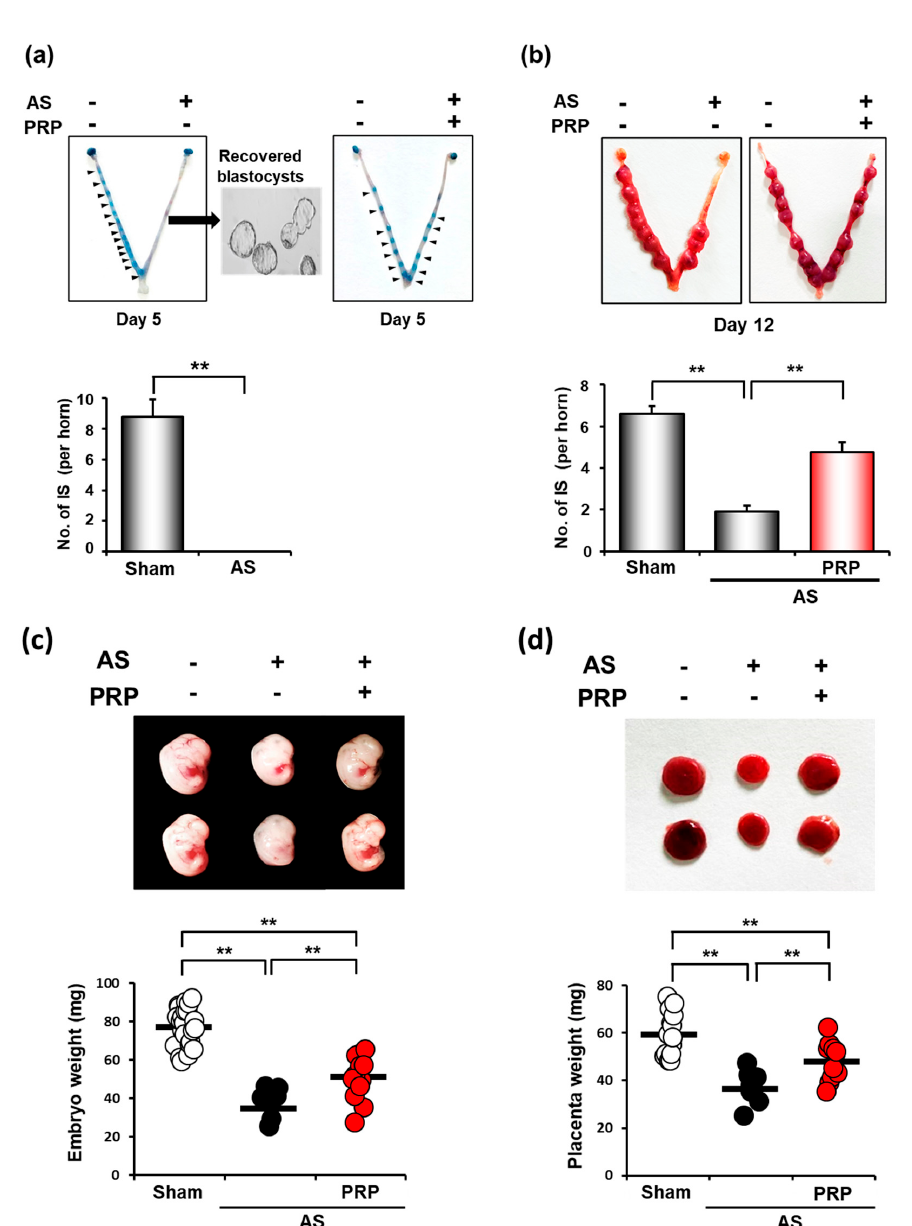
Figure 4. hPRP restores compromised uterine milieu for embryo implantation and subsequent pregnancy in mice with AS. ( a ) Failure of embryo implantation in the uterus of mice with AS in the morning of day 5 of pregnancy. Healthy unimplanted blastocysts were successfully retrieved from the uterus of mice with AS on day 5 of pregnancy. Note that hPRP therapy allows ‘on-time’ embryo implantation in mice with AS (blue bands along the right horn of the uterus with AS after hPRP treatment in the right box). ( b ) The representative images of the uterus and the number of implantations sites (ISs) in mice with AS after hPRP treatment on day 12 of pregnancy. Note that PRP treatment significantly increased the number of ISs in mice with AS on day 12 of pregnancy. ( c , d ) Representative images (upper images) and distribution graphs (bottom) of weights of embryos ( c ) and their placentas ( d ) that were harvested from ISs in mice with AS after hPRP treatment on day 12 of pregnancy. Note that hPRP treatment significantly increased the number of ISs and weights of embryos and placenta in mice with AS. The horizontal black lines represent the median values of weights of embryos ( c ) and their placentas ( d ). ** p <